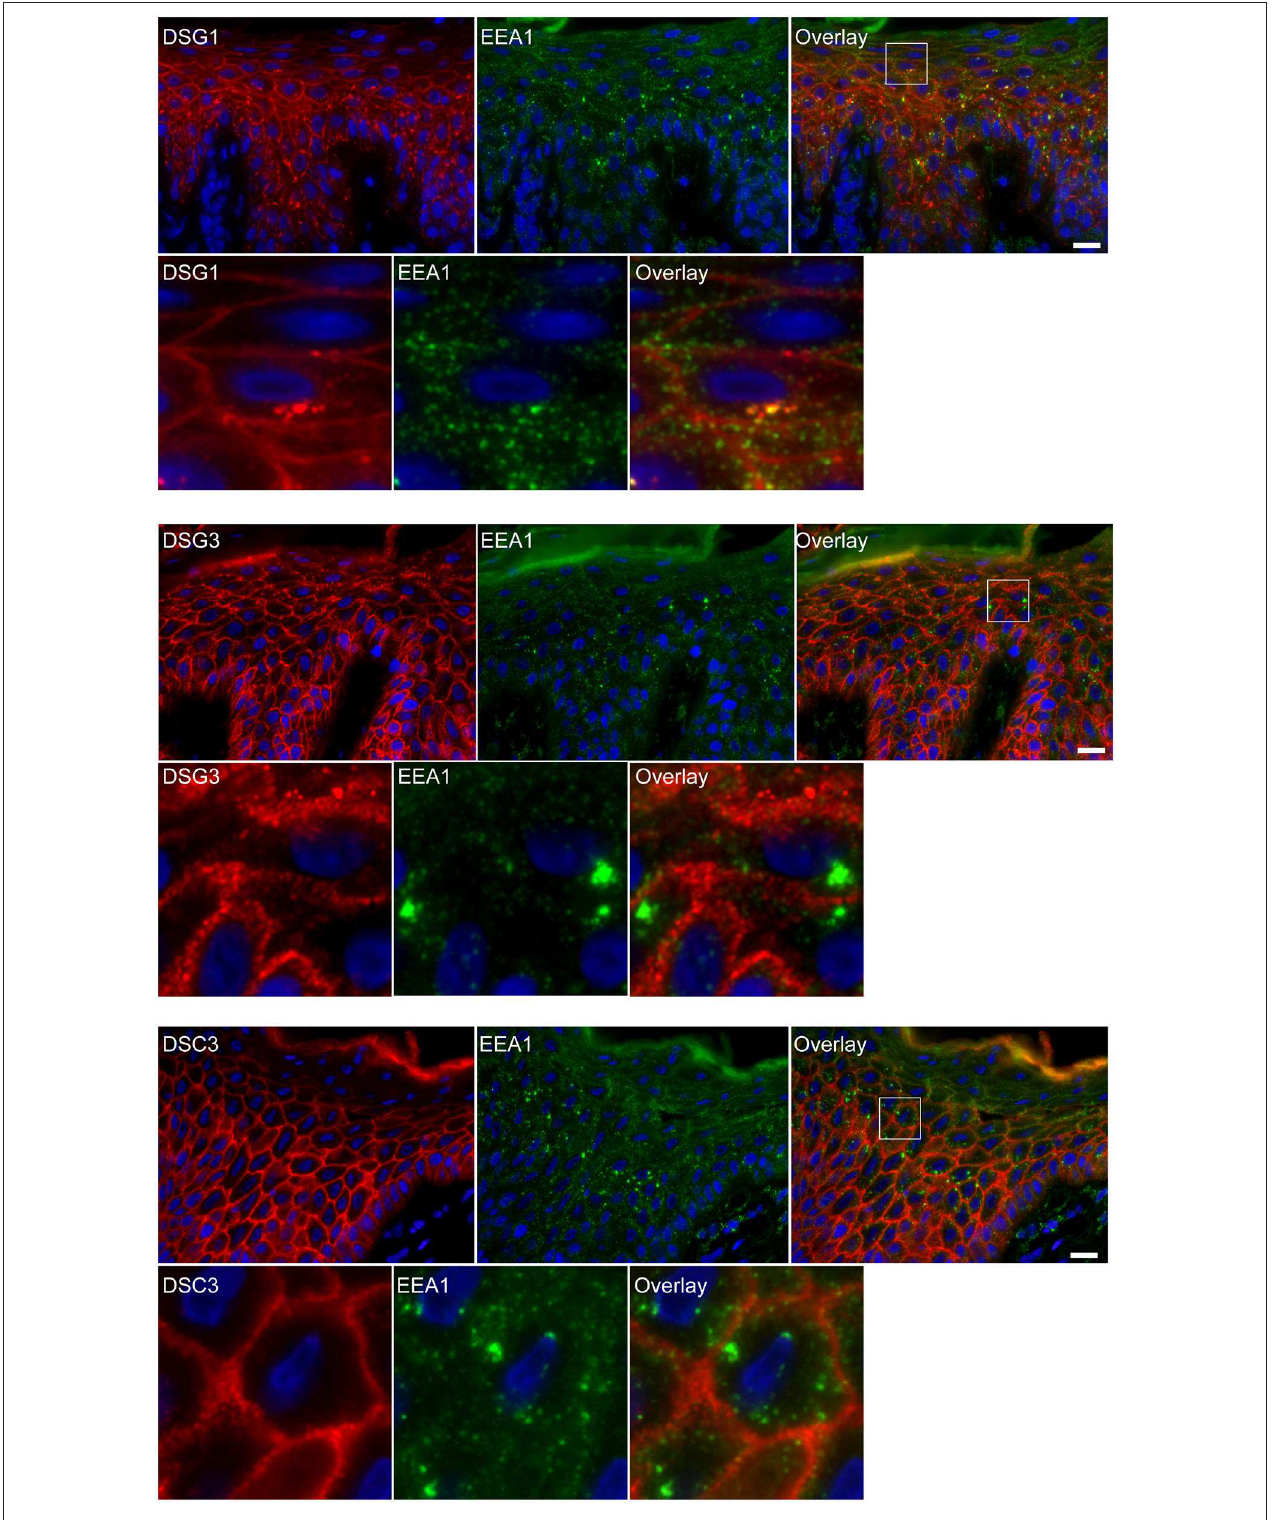
FIGURE 3 | Double staining shows colocalization of EEA1 with desmoglein 1 but not with desmoglein 3 and desmocollin 3. The upper panels show the overviews, the lower panels shows the details from the white boxes in the upper panels. White bar is 20 µ m.